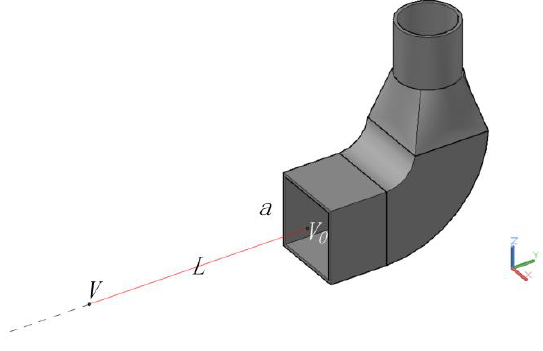
Figure 2. The variables used in this study.